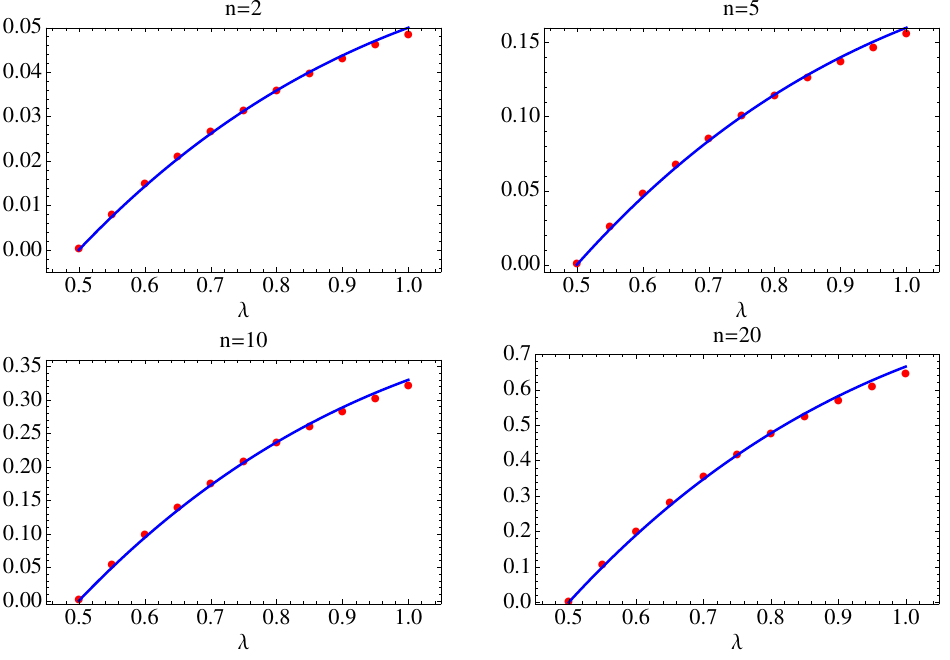
Figure 7 . ∆ -sum rule in the two-particle approximation (red dots) compared to the exact formula (solid blue line) for n = 2 , 5 , 10 , 20 and 1